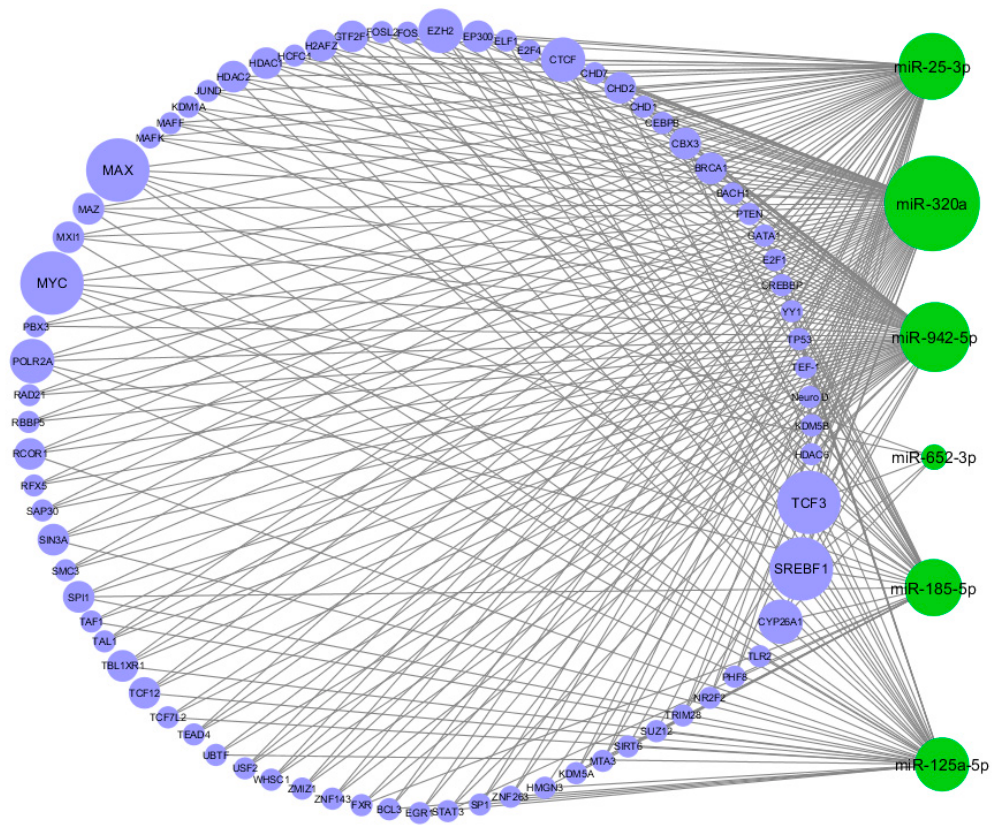
Figure 4. Circular view of transcription factor-miRNA (TF-miRNA) interactions. Green nodes represent the miRNAs, blue nodes represent the TFs. The size of the nodes is proportional to the degree of the nodes (number of incoming and outcoming edges). As shown in the figure, the four biggest TF nodes are MAX, MYC, TCF3, and SREBF1.